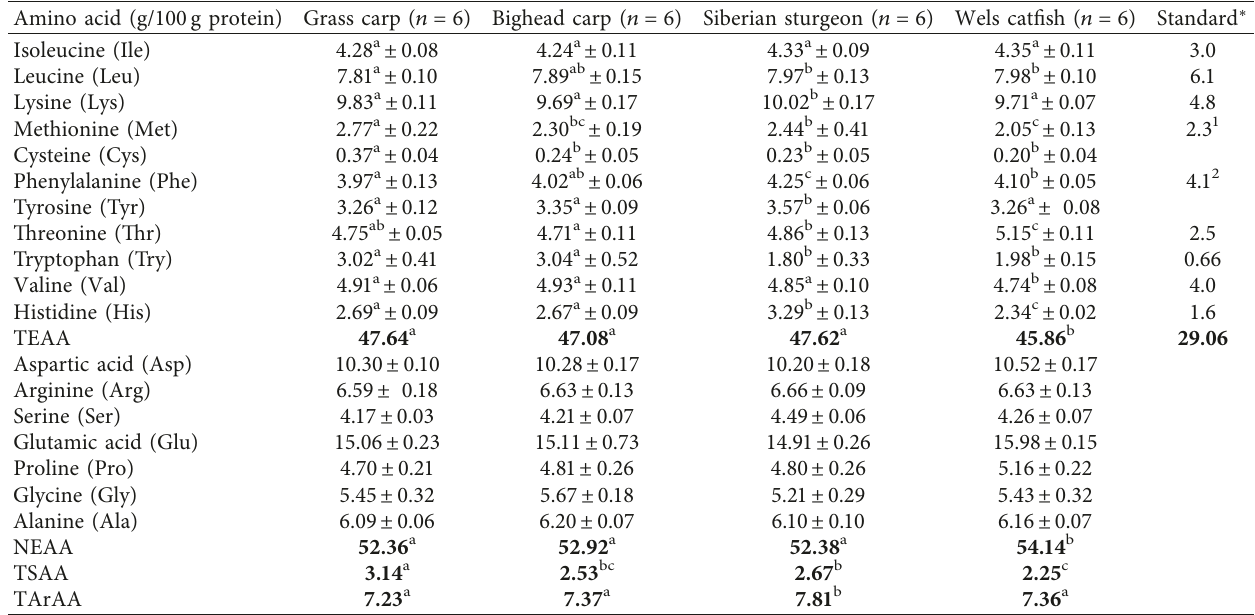
Table 3: Amino acid profile of protein of grass carp, bighead carp, Siberian sturgeon, and wels catfish (mean value ± SD). Amino acid (g/100g protein) Grass carp ( n � 6) Bighead carp ( n � 6) Siberian sturgeon ( n � 6) Wels catfish ( n � 6) Standard